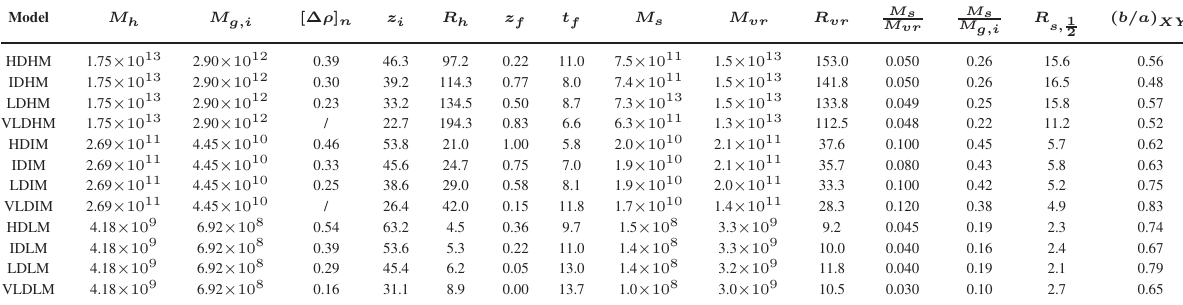
density unchanged. Playing with this, a number of proto-haloes with the same mean density but smaller mass and consequently radius are generated. The initial redshifts of the proto-haloes with equal initial density but different mass are different from one another, because the exit time (redshift) from the linear regime is a function of the mass of the perturbation. Table 1. Initial parameters and final properties (at the last computed stage of their evolution) of the NB-TSPH galaxy models. From left to right: the model identification code [xDyM, where D stands for density and M for mass; x stands for H (high), I (intermediate), L (low) and VL (very low)], the initial total halo mass M , the initial total baryon mass (in h form of gas) M , the relative over-density with respect to the background density when the g,i primordial perturbations exit the linear regime ( [∆ ρ ] at which = δρ − ρ u 1 ), the redshift z n i ρ u − the proto-halo is sorted out of the background, the associated proper radius R , the redshift h of the last computed model, the age t at the same stage, the total galaxy mass M in stars, z f f s the total mass (DM + gravitationally bound BM) of the virialized halo M , the associated vr virial radius R (for all models virialization roughly occurs at about 2 Gyr), the ratio of vr the total star mass to the virial mass M , the ratio of the total star mass to initial gas /M s vr mass M , the half star-mass radius R , the axial ratio ( b/a ) of the stellar system /M s g,i XY s, 1 / 2 projected on the XY plane. Times are in Gyr, masses in solar units M , and radii in kpc. ⊙ Model M h M